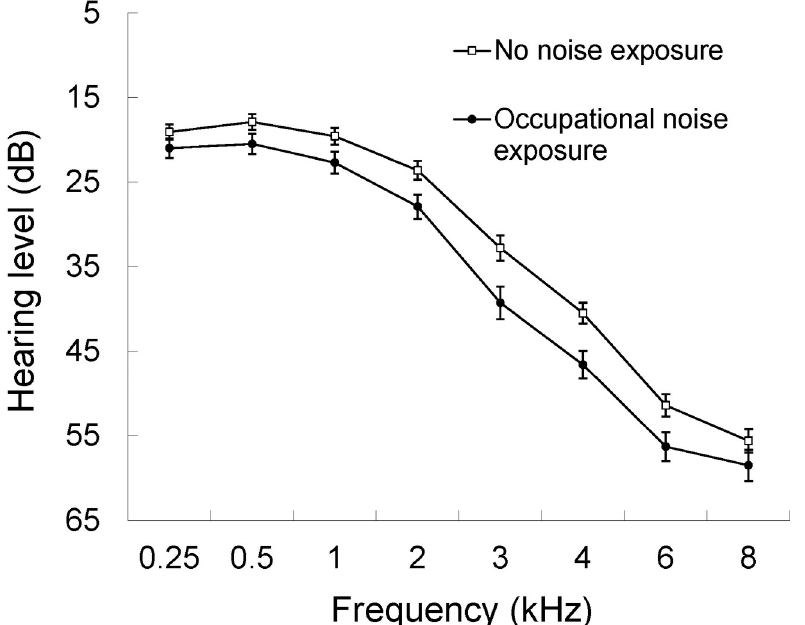
Fig 2. Mean air-conduction thresholds at baseline in those with or without occupational noise exposure. Age- and sex-adjusted mean hearing thresholds for participants who did not report occupational noise exposure, pure-tone average threshold 0.25–8 kHz, � 25 dB HL ( □ ); age and sex adjusted mean hearing thresholds for participants who reported occupational noise exposure, pure-tone average threshold 0.25–8 kHz, > 25 dB HL